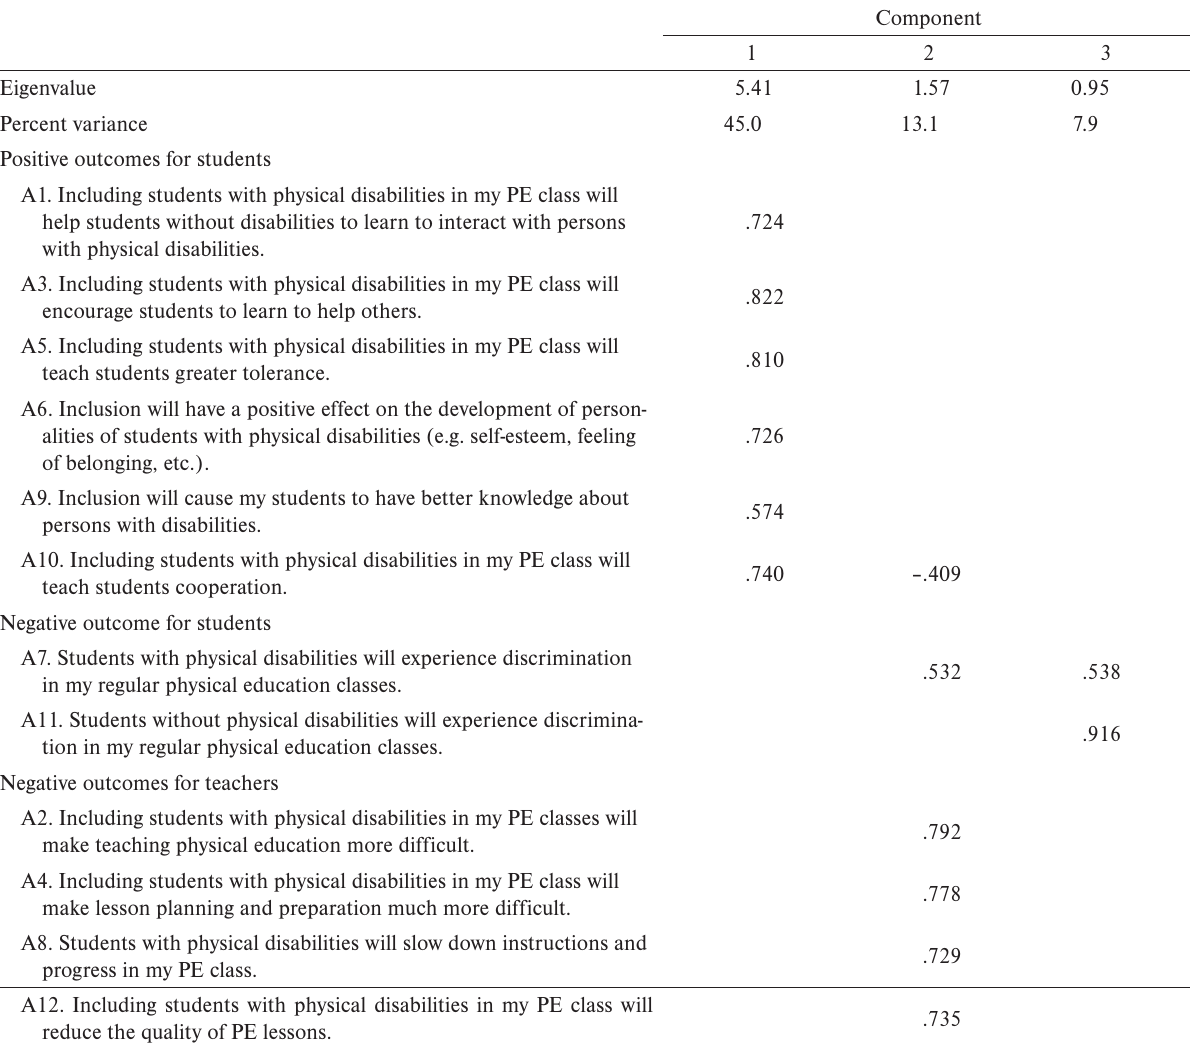
Table 3 Matrix of factor loadings for principal component analysis with varimax